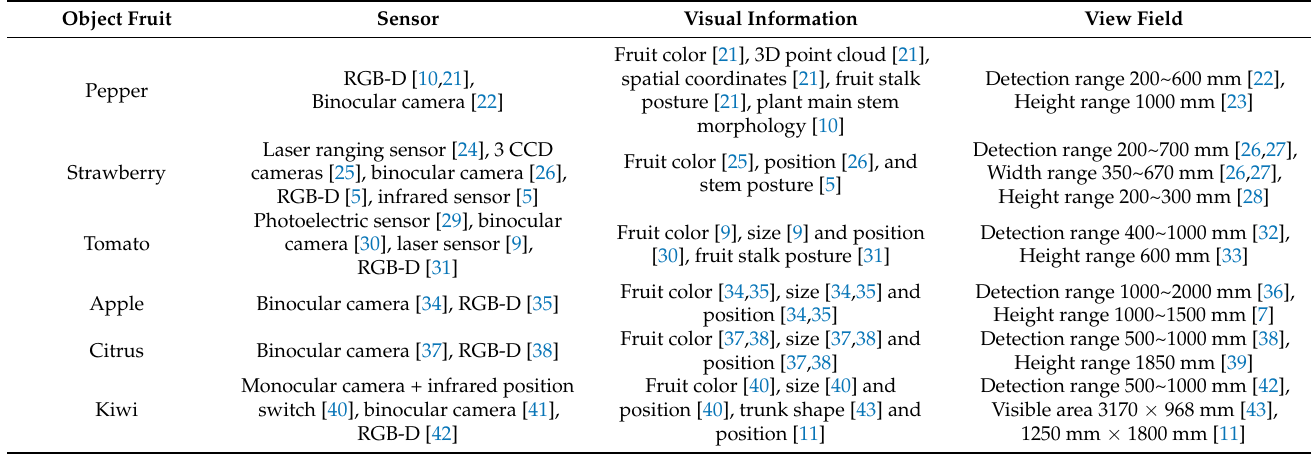
Table 1. Characteristic list of some harvesting robots’ visual units.